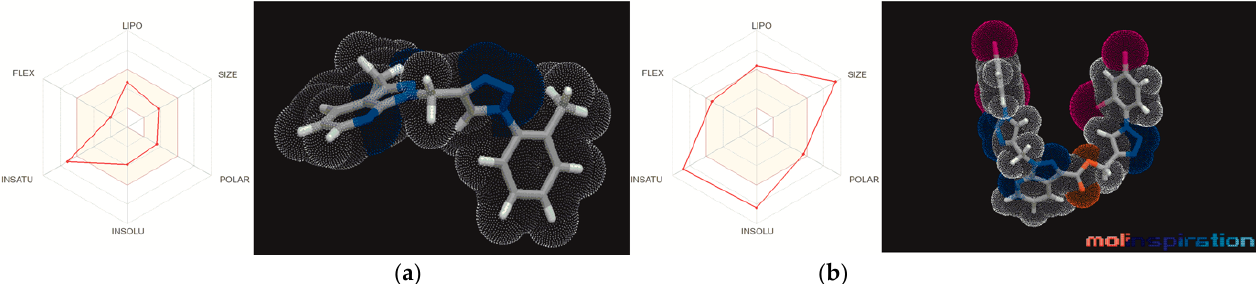
Figure 3. Web and MLP representation of physico-chemical properties of ( a ) Compound 14 and ( b ) Compound 30 .